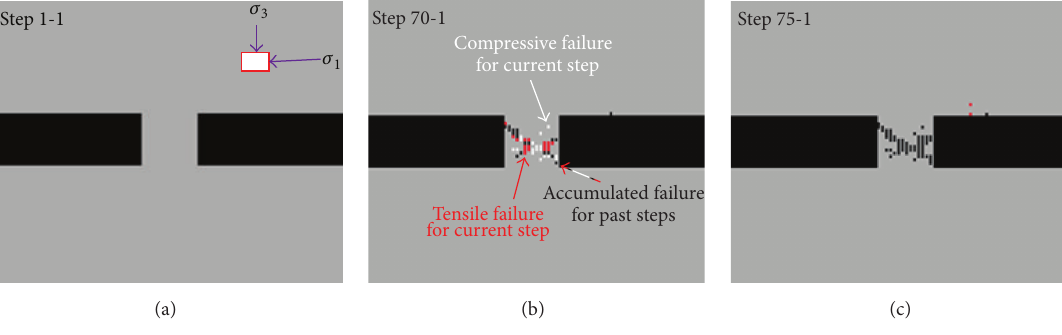
Figure 8: Plot of acoustic emissions for a pillar with width-to-height ratio =